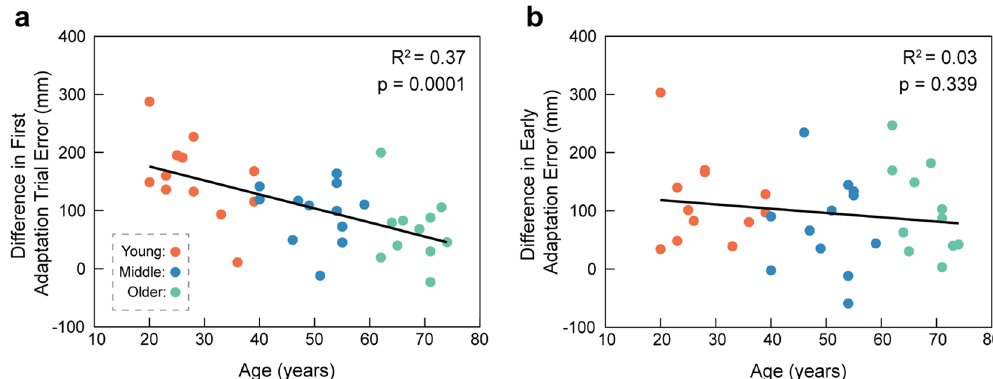
Figure 4. Relationship between aging and initial recall or savings. ( a ) Scatter plot illustrating the relationship between age and the difference in first adaptation trial foot-placement error between testing sessions. ( b ) Scatter plot illustrating the relationship between age and the difference in early adaptation foot-placement error between testing sessions. Testing sessions occurred one week apart. The solid lines show the linear fits obtained from the regression